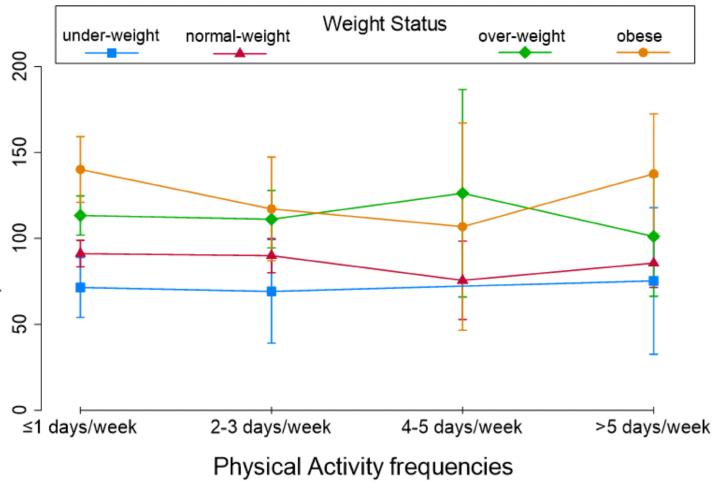
Table 3. Predictors of FID, FAI, and BSQ: multiple regression analysis results.